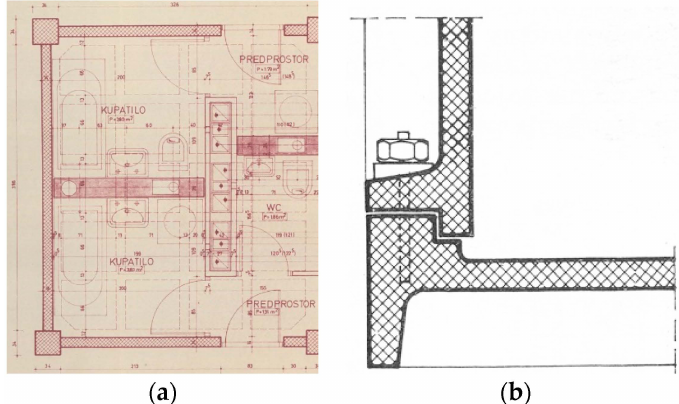
Figure 16. ( a ) Installations’ panel with ventilation ducts ( b ) mechanical joint between sanitary block with floor slab (source: original drawing sheet from Historical Archives of New